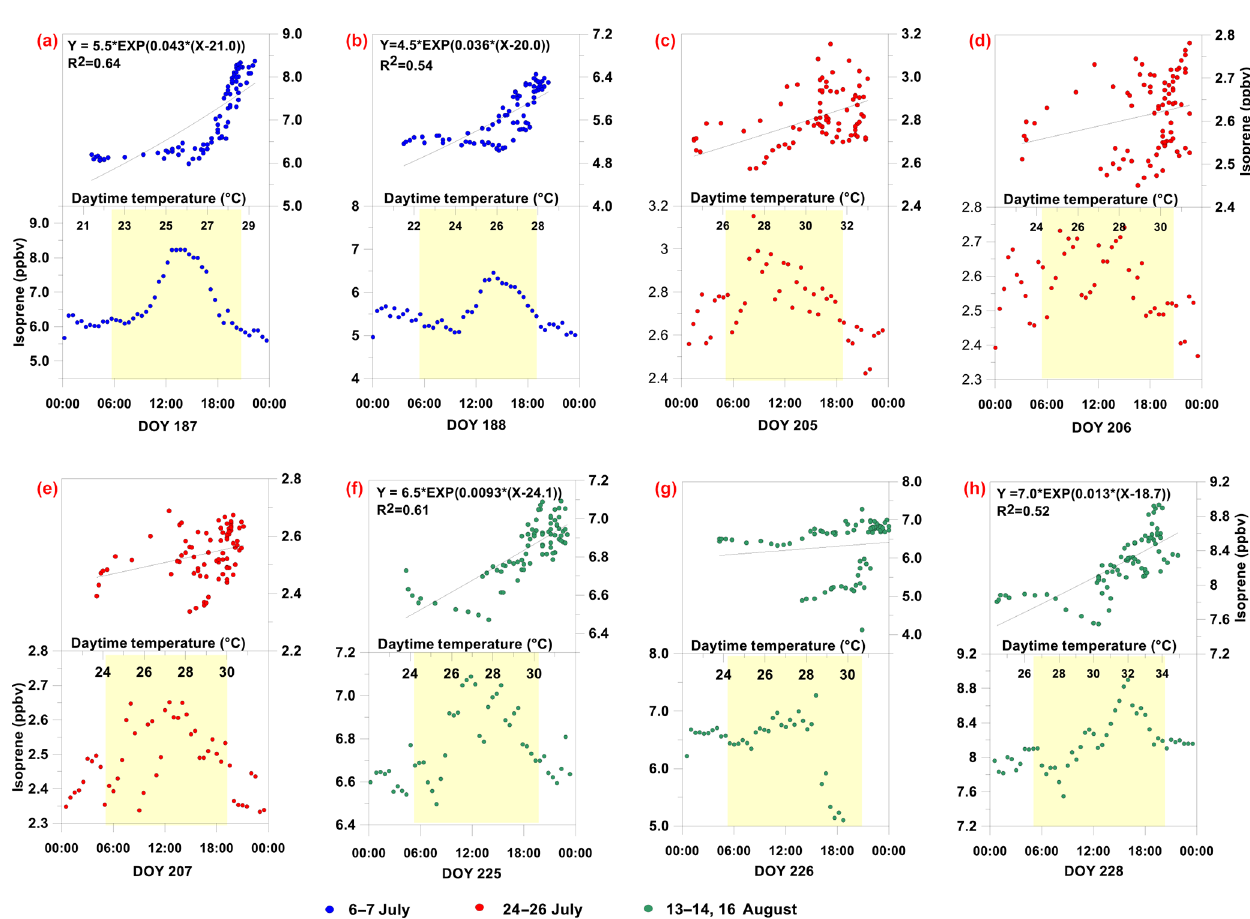
Figure 6. Isoprene (m87 / m69 < 13%) diurnal average mixing ratio and dependence on temperature. Upper panels show scatter plots be- tween measured m87 / m96 < 13% and temperature, as well as the corresponding regression equation and nonlinear exponential coefficient ( R 2 ) in cases when R 2 > 0 . 50. Lower panels present that of m87 / m96 < 13%. Yellow shaded areas represent daylight